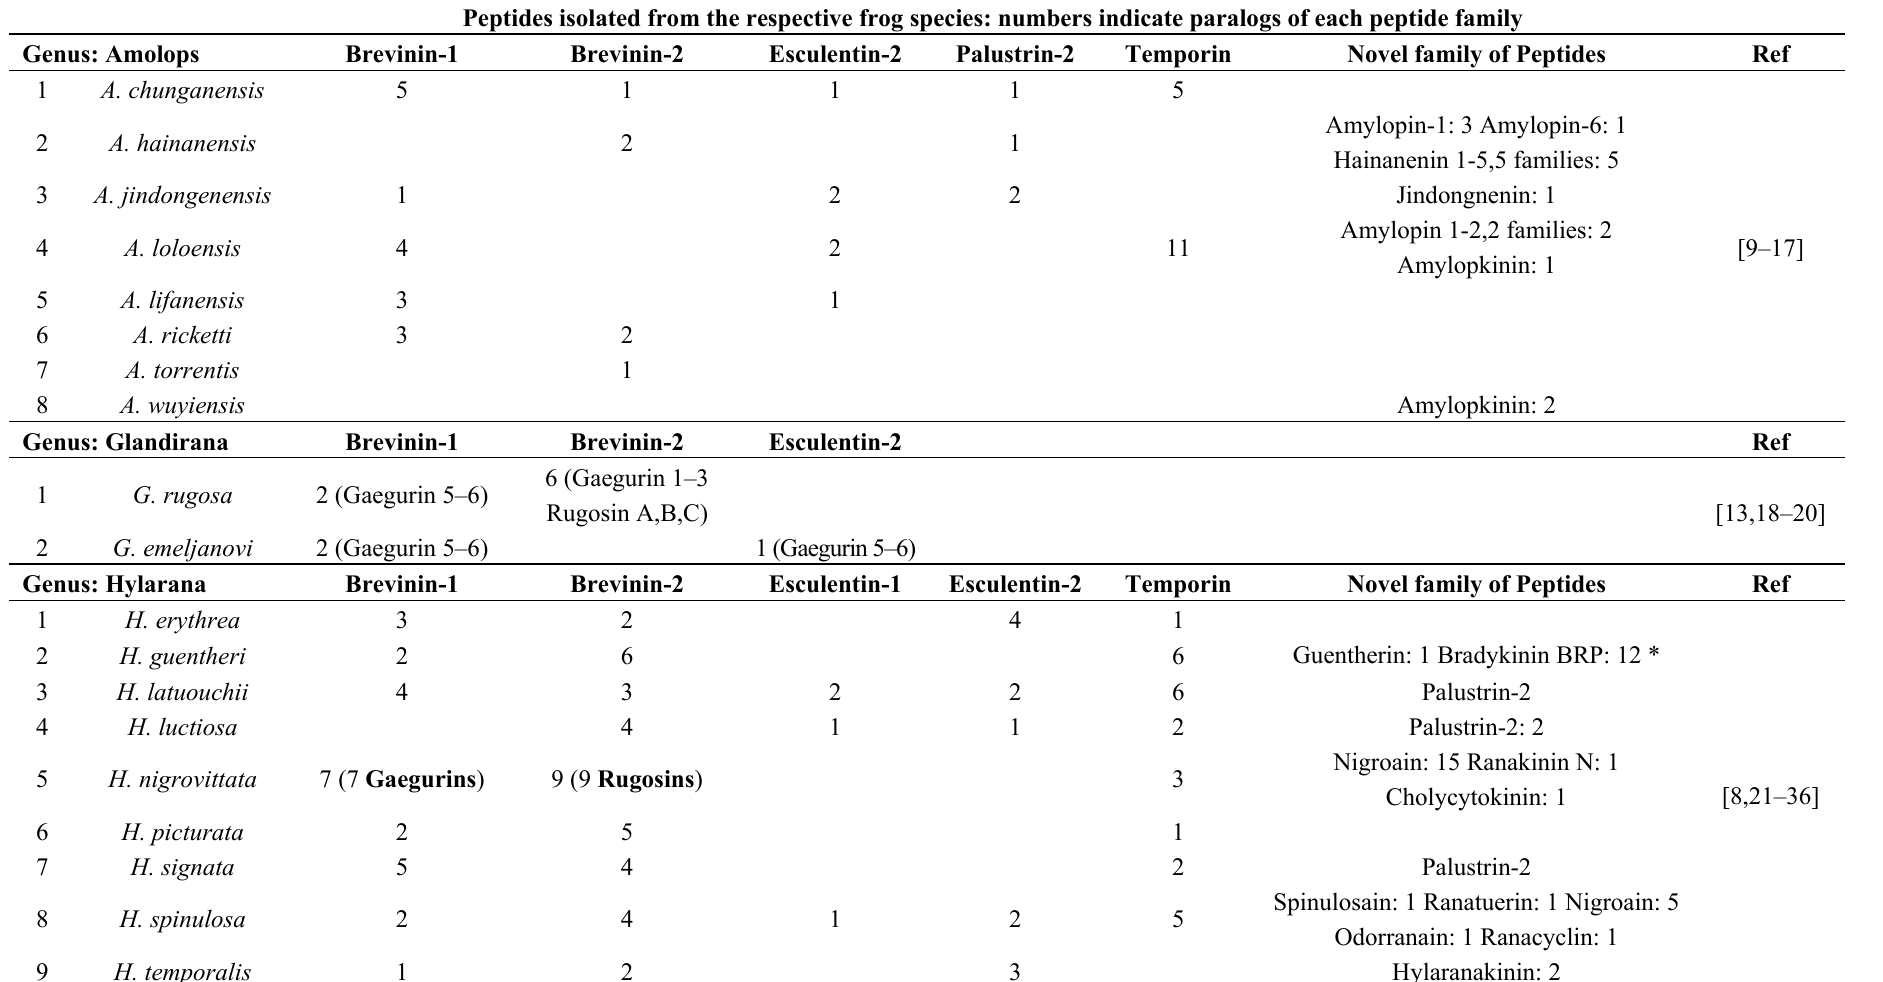
Table 1. List of peptides identified from the skin secretion of Asian frogs. Peptides isolated from the respective frog species: numbers indicate paralogs of each peptide